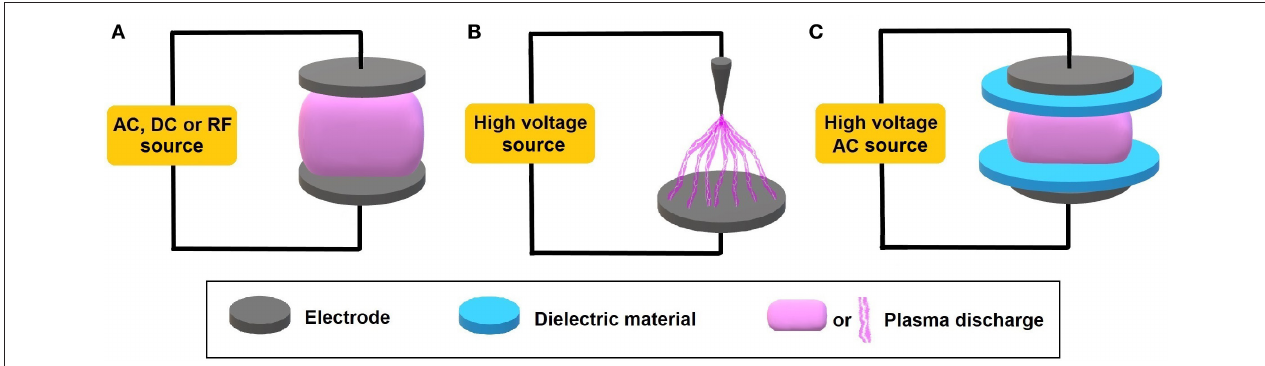
FIGURE 1 | Simplified illustrative scheme of commonly used plasma discharges based on the voltage source and electrode geometry. (A) Glow discharge; (B) corona discharge; (C) dielectric barrier discharge (DBD).